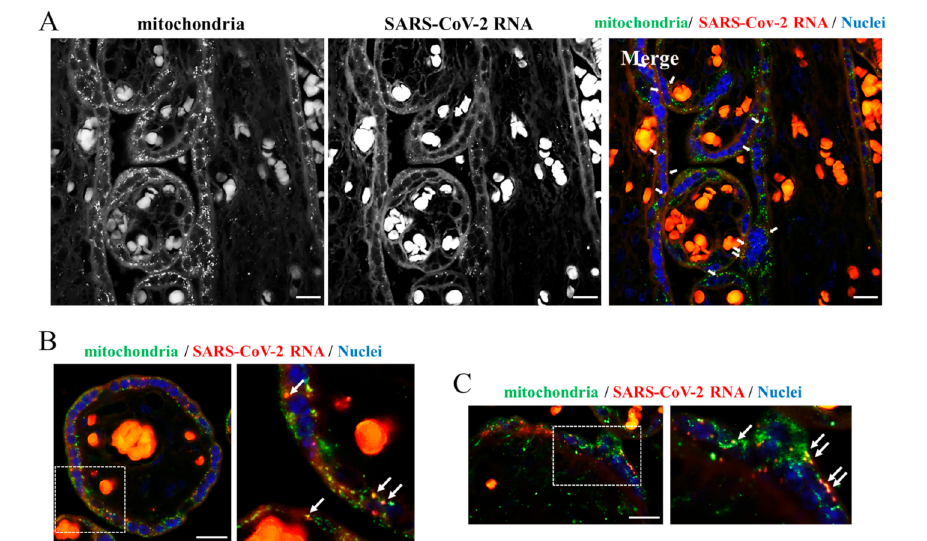
Figure 4. Dual staining of placenta sections. ( A – C ) Sections from the SARS-CoV-2 positive placenta were subjected to a combination of the padlock and immunofluorescence assays to visualize the SARS-CoV-2 RNA (red in the color images) and mitochondria (green in the color images). In panel ( A , B ), HSP60 was used as mitochondrial marker. In panel ( C ), COX IV was used as mitochondrial marker (green in the color panels). SARS-CoV-2 RNA (red in the color panels) results partially overlapped with both mitochondrial markers in the Merge panel (yellow dots). In panel ( B , C ), a higher magnification of a selected region is shown. Scale bar, 20 µ